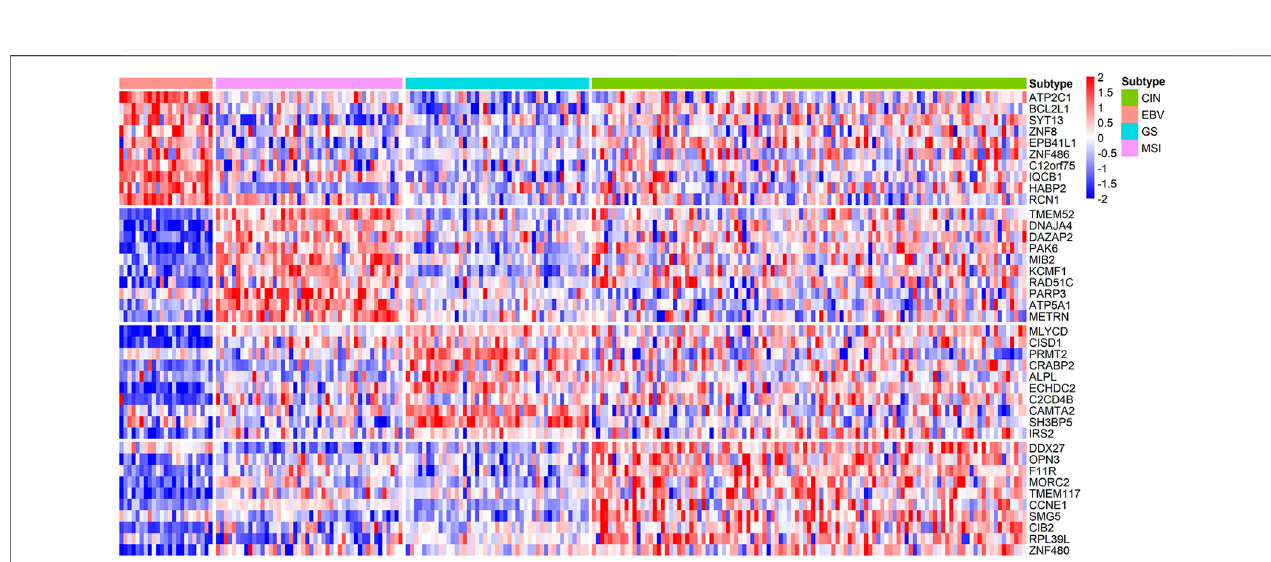
FIGURE 8 | Heatmap of the z-score normalized gene expression of the molecular subtype-speci fi c biomarker genes in STAD. Green bar, pink bar, blue bar, and purple bar at the top represent CIN, EBV, GS, and MSI subtype, respectively.